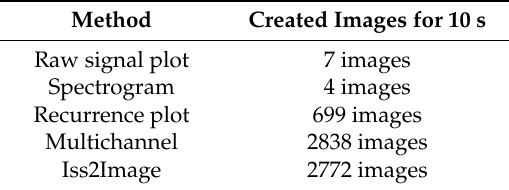
Table 9. Comparison of image creation time on different signal transformation methods.